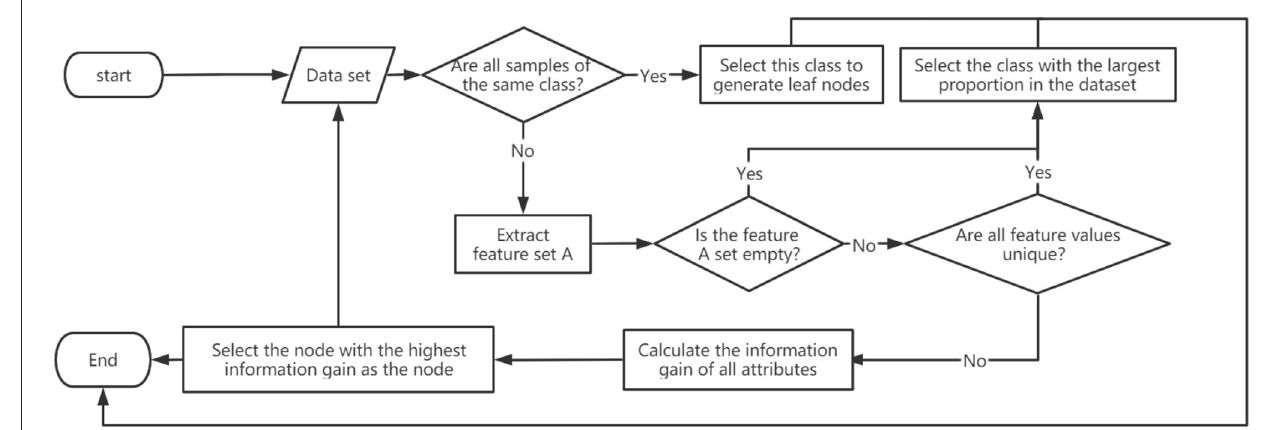
FIGURE 4 | ID3 algorithm flowchart.